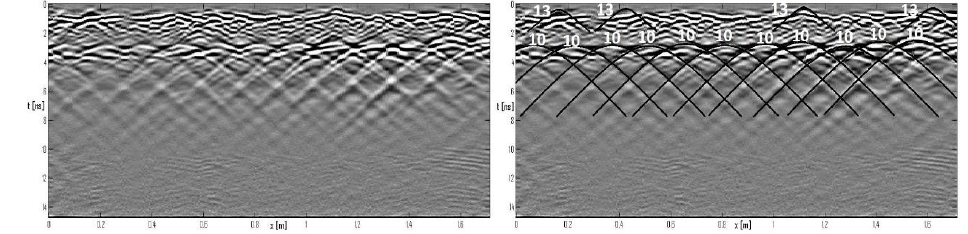
Figure 8. Pre-migrated data. The applied processing was intended to make the diffraction hyperbolas clearer. The Bscan is the same on the left- and right-hand panels. On the right-hand side, model diffraction hyperbolas are superposed to the data so as to match them. The procedure is manual. The numbers on the hyperbolas indicate the trial propagation velocity in cm/ns.